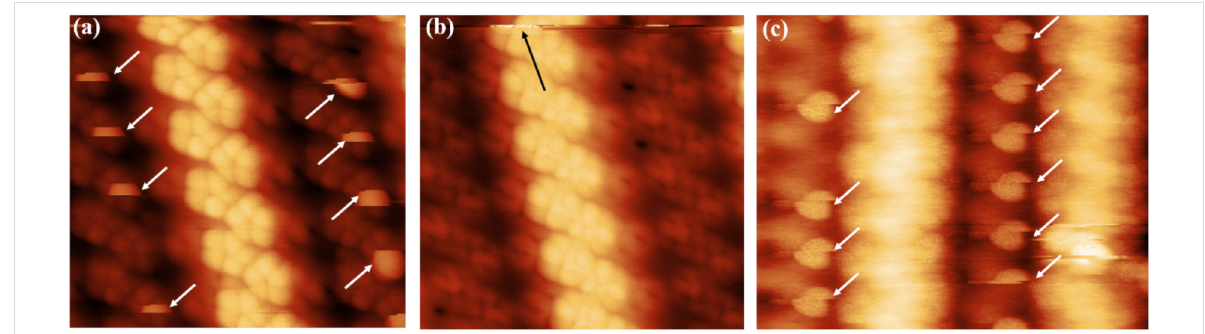
Figure 3: (a) An AFM image (7 × 6 nm 2 ) of the 16×2 reconstruction surface with protrusions on L-P3 sites. White arrows indicate the protrusions. The fast scan direction is left to right, the slow scan direction is top to bottom. (b) An AFM image in the same area as (a). The tip state changed in the posi- tion indicated by the black arrow. The scan direction is the same as (a) ( f 0 = 162.0 kHz, A = 5 nm, V s = 0 mV, T = 78 K, Δ f = 17 Hz). (c) An AFM image (10 × 8 nm 2 ) of the 16×2 reconstruction surface with protrusions by using a different tip from Figure 3a ( f 0 = 155.9 kHz, A = 5 nm, V s = 0 mV, T = 78 K, Δ f = 7 Hz).